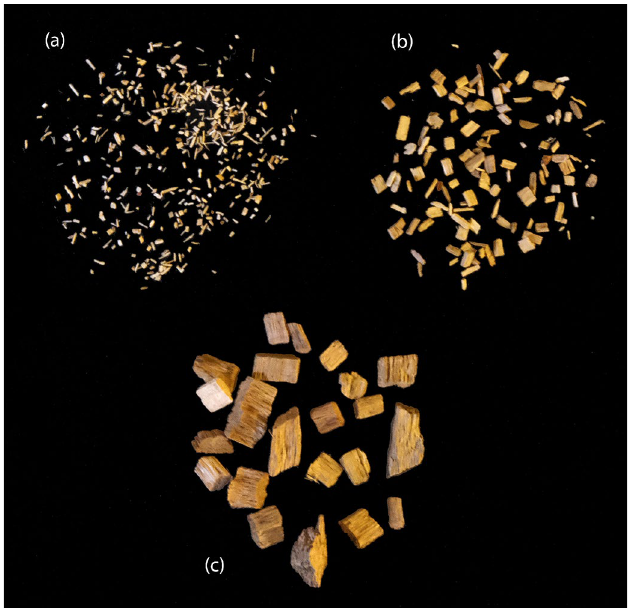
Figure 7. Beech wood particles of small ( a ), medium ( b ) and large ( c ) granulation used in this study.